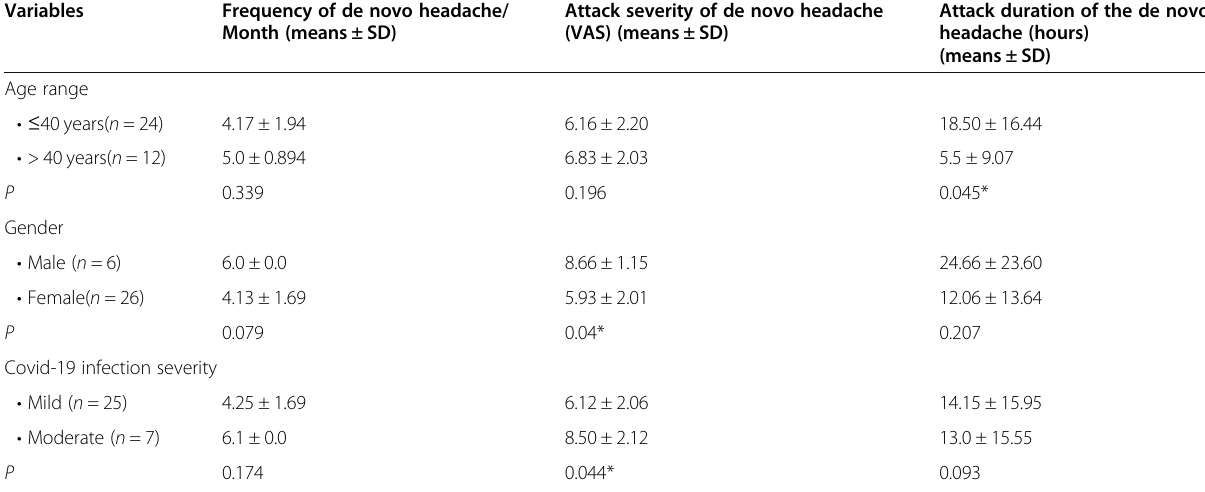
Table 6 Characteristics of the de novo headache post- COVID-19 infection in relation to age, gender and severity of COVID-19 infection